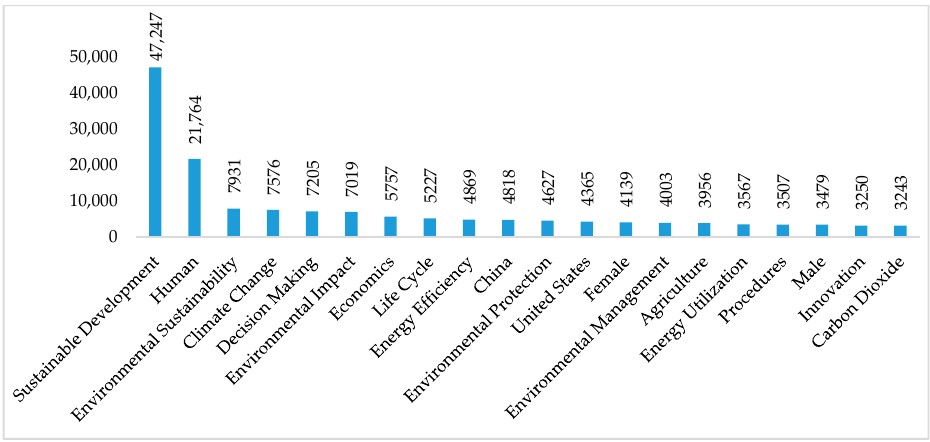
Figure 3. Sustainability research topics between 2011 and 2020.